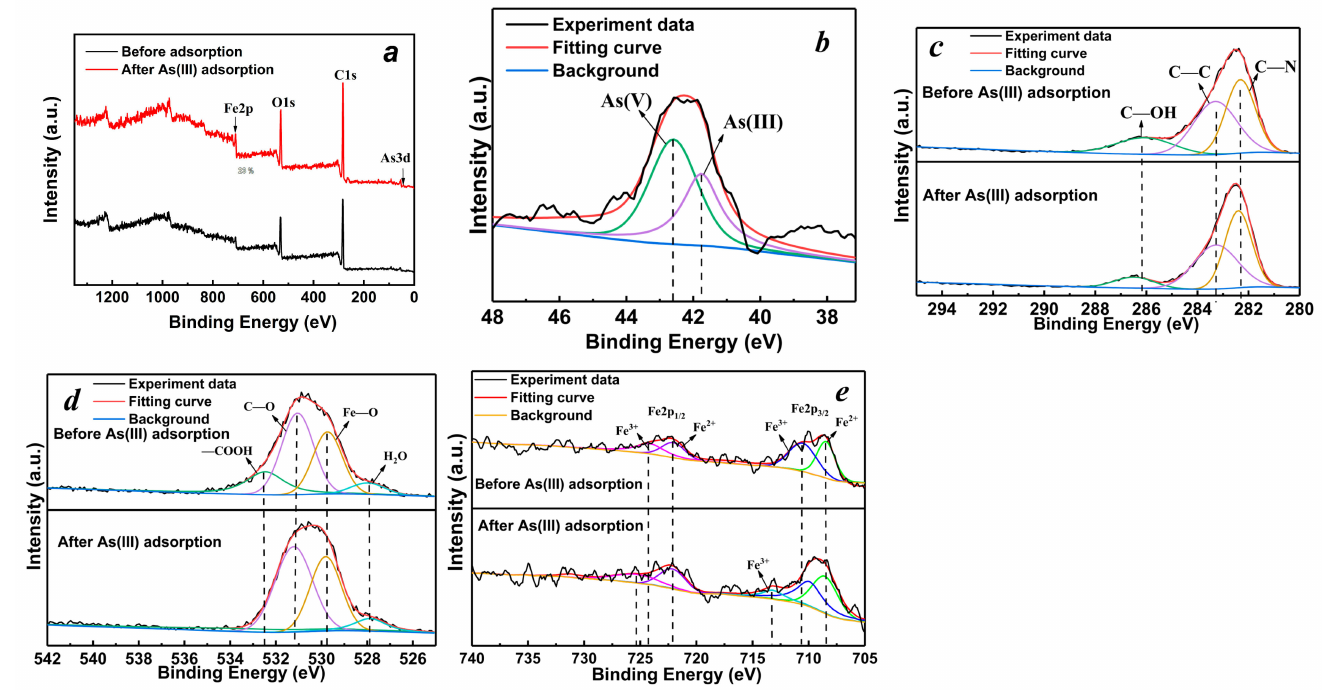
Figure 6. The XPS all-scan spectra of ( a ) MGOCS and XPS response of ( b ) As3d, ( c ) C1s, ( d ) O1s, and ( e ) Fe2p before and after As(III)